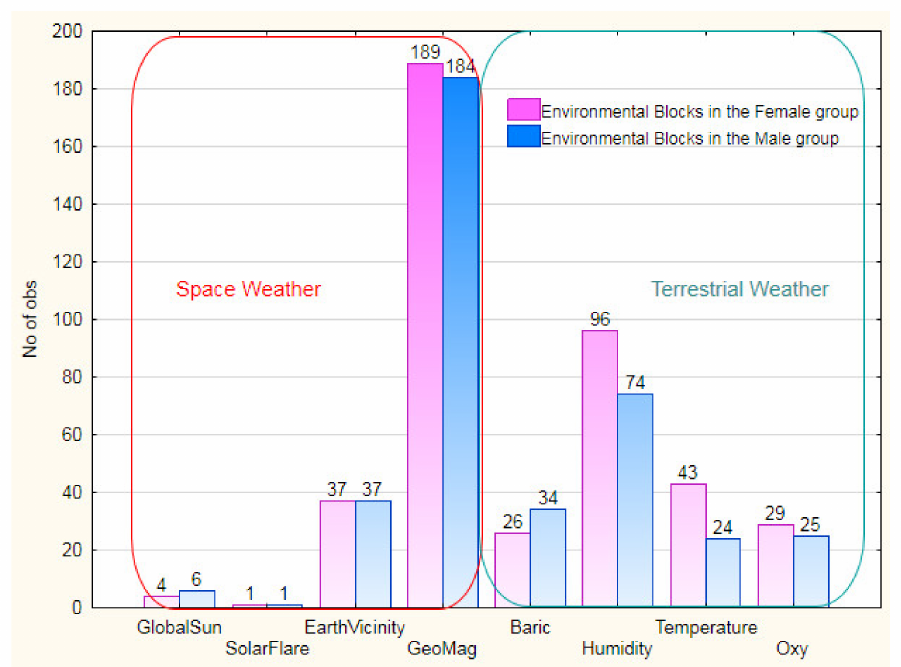
Figure 10. The distribution of the Space Weather and Terrestrial Weather characteristics, which differ when they are correspond to the different medical events, by the environmental blocks. Block names: global solar activity variations (GlobalSun), variations of the solar activity flare component (SolarFlare), variations of the particle fluxes and X-ray fluxes in the Earth’s vicinity (EarthVicinity), variations of the geomagnetic characteristics (GeoMag), variations of pressure systems characteristics (Baric), variations of the humidity characteristics (Humidity), variations of the air temperature characteristics (Temperature) and variations of the air oxygen weight content characteristics (Oxy). Summary for both gender